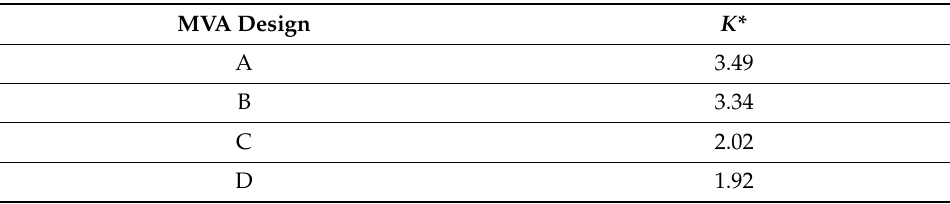
Table 5. Thermal conductivity ratio for each MVA